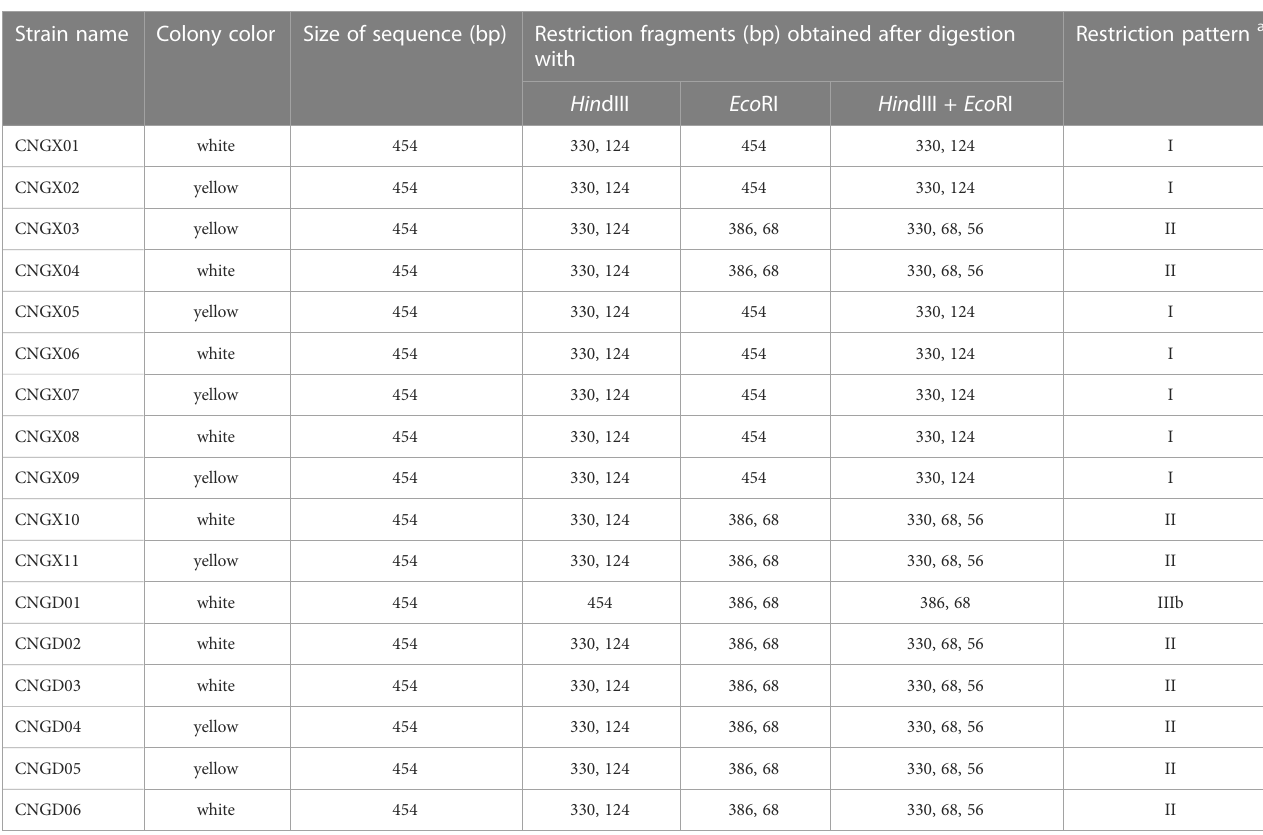
TABLE 1 In silico analysis of RFLP patterns of 17 strains of Acidovorax avenae subsp. avenae from sugarcane in China based on the internal transcribed spacer (ITS) region of 16S-23S